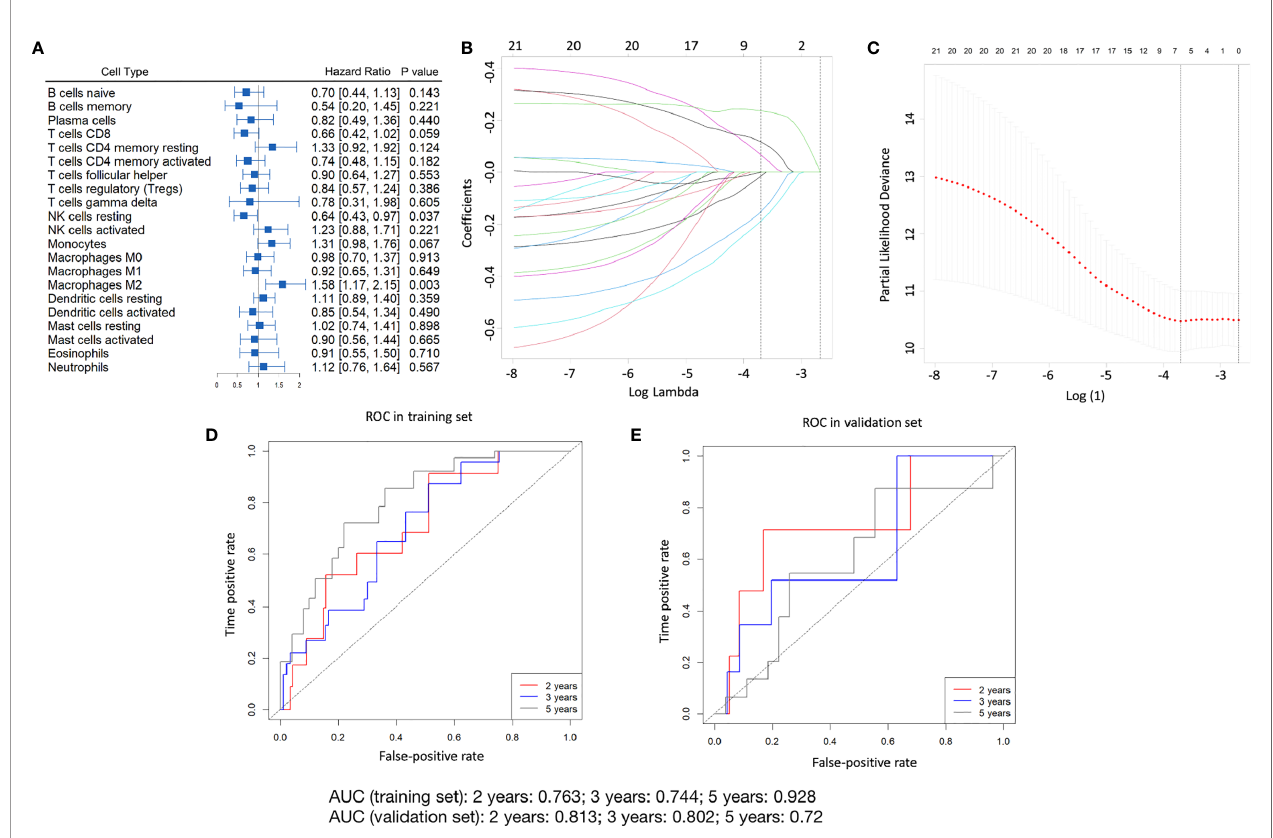
FIGURE 2 | Construction of the immunoscore model. (A) The forest plot shows the relationship of different subpopulations of immune cells to OS in the training set. (B) Distribution of LASSO factors for 21 immune cell fractions. The dashed curve represents values selected via 10-fold crossover validation. (C) Crossover validation of a 10-fold choice of adjustment parameters from the LASSO model. The bias likelihood deviation was expressed in log( l ) whenever l was the adjustment parameter. Values of the bias-likelihood deviation are displayed, and the error bands indicate S.E. of the mean according to the minimal criterion and the 1-S.E. criterion; vertical dashed lines were plotted at the optimal point. Numbers at the top denote numbers for cell categories implicated in the LASSO model for (B, C) The prognostic accuracy of the immunoscore as a continuous variable as assessed by ROC analysis in the training set (D) and validation set (E)